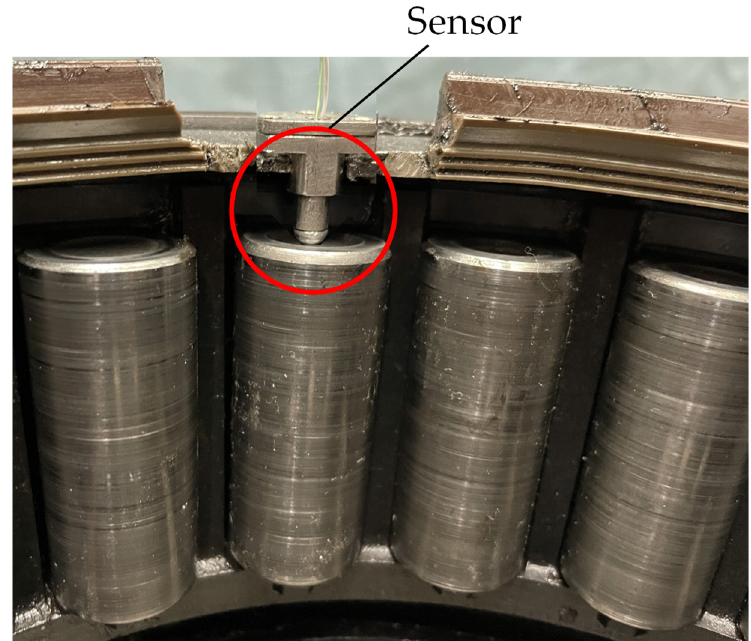
Figure 8. Sensor mounting position.